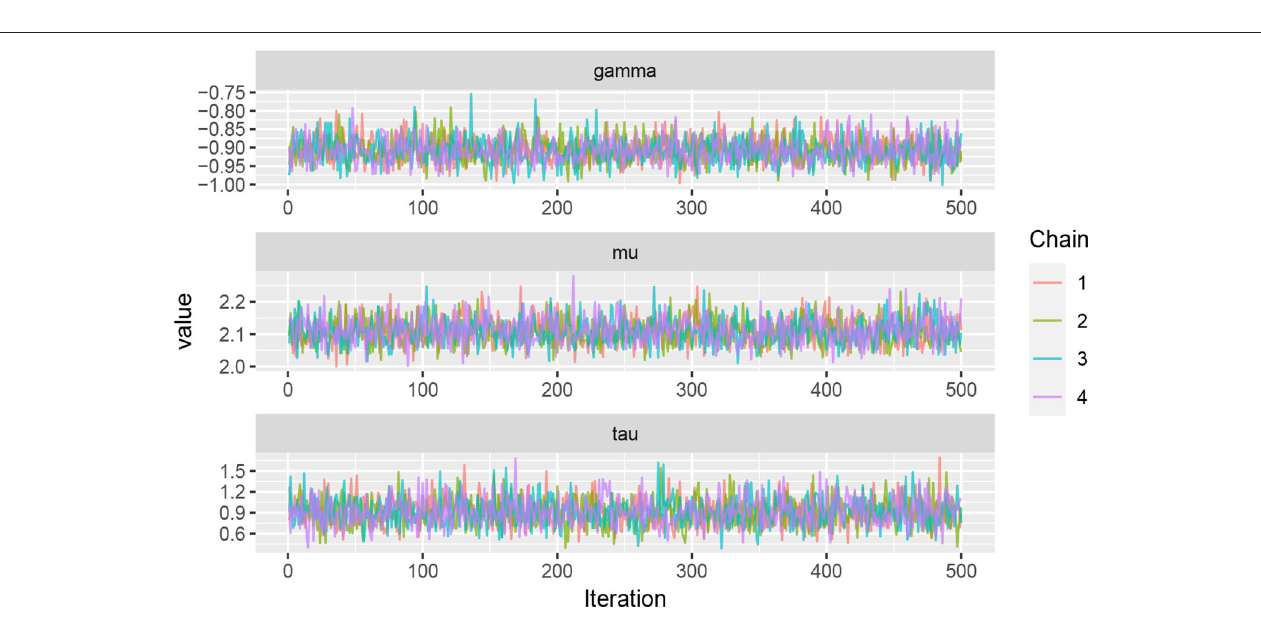
FIGURE 4 | Traceplots of generated samples of size n